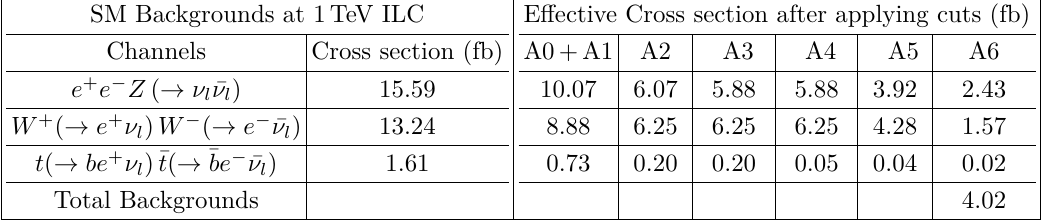
Table 4 . Cut-flow table for the obtained cross sections corresponding to the different SM back- grounds. See the text for the details of the cuts A0-A6. The c.m.energy is ILC.